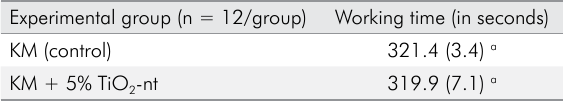
Table 1. Mean (standard deviation) working time (in seconds) of the experimental group.